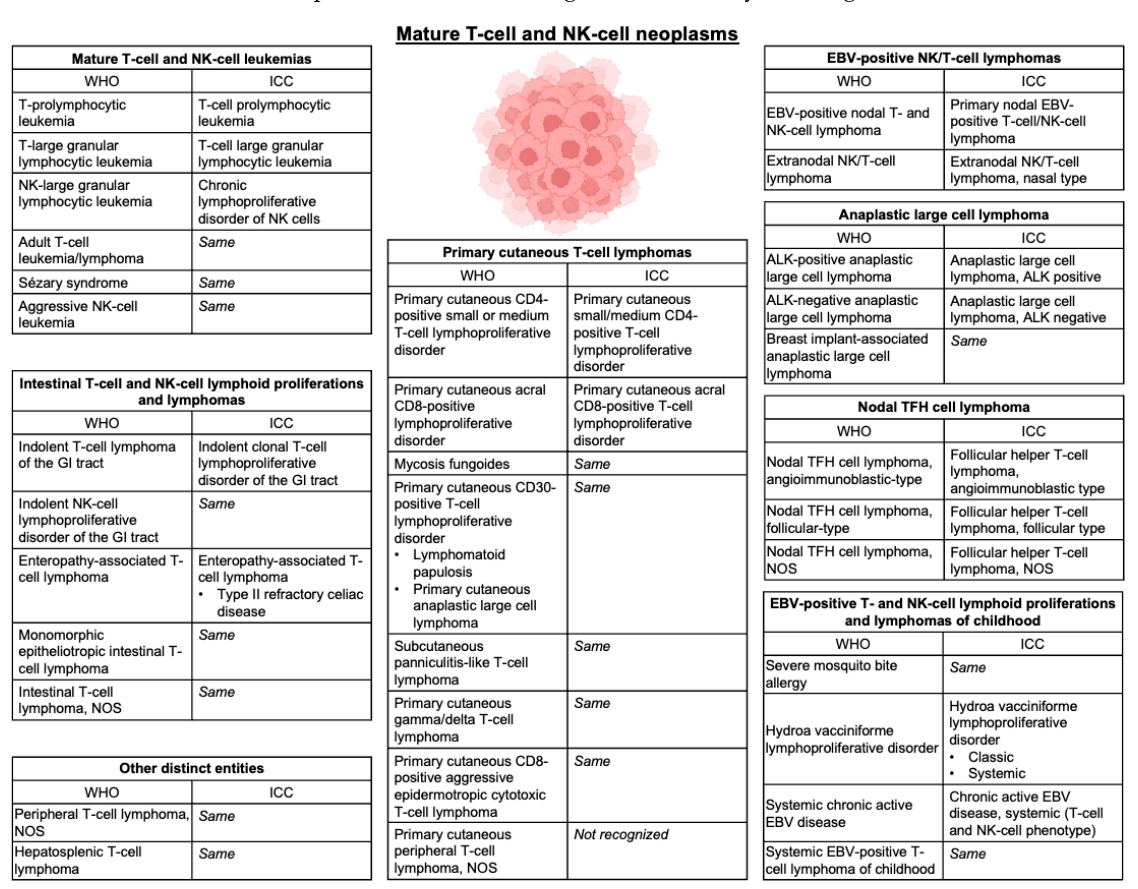
Figure 1. Classification of mature T- and NK-cell lymphomas. Updated classification of mature T- and NK-cell neoplasms depicted in accordance with the World Health Organization (WHO) Classification of Hematolymphoid Tumors, 5th edition [2]. Nomenclature is compared to the International Consensus Classification (ICC) of Mature Lymphoid Neoplasms [3]. Abbreviations—NOS: not otherwise specified; GI: gastrointestinal; EBV: Epstein–Barr Virus; TFH: T-follicular helper; ALK: anaplastic lymphoma kinase.